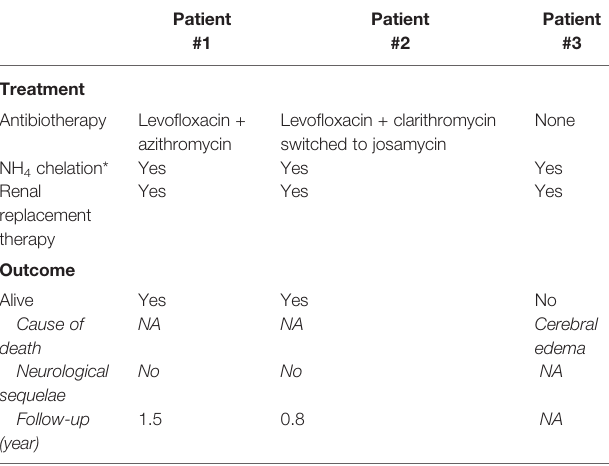
TABLE 2 | Therapeutics and outcome of the 3 newly reported patients.